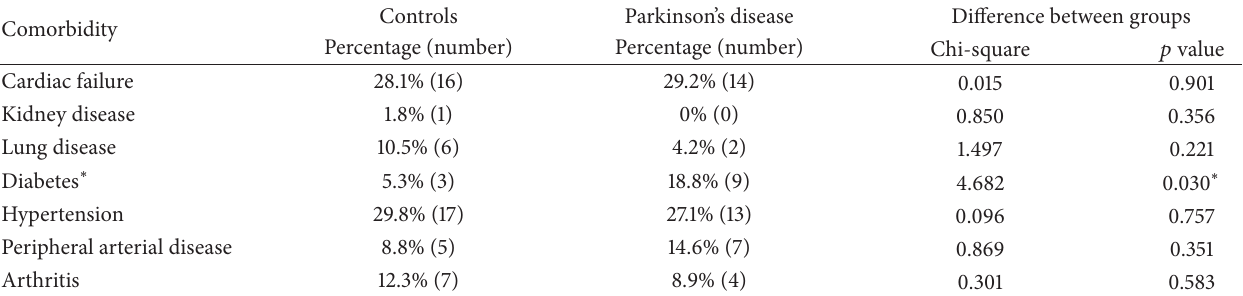
Table 1: Comorbidities for both groups; ∗ 𝑝 < 0.05